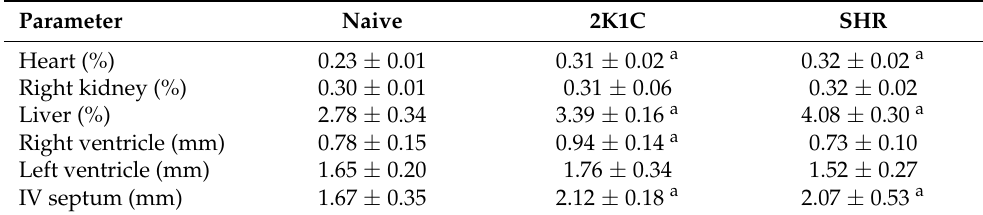
Table 6. Relative organ weight and cardiac morphometry of the different experimental groups at the end of 6 weeks of treatment with the high-fat diet. Parameter Naive 2K1C